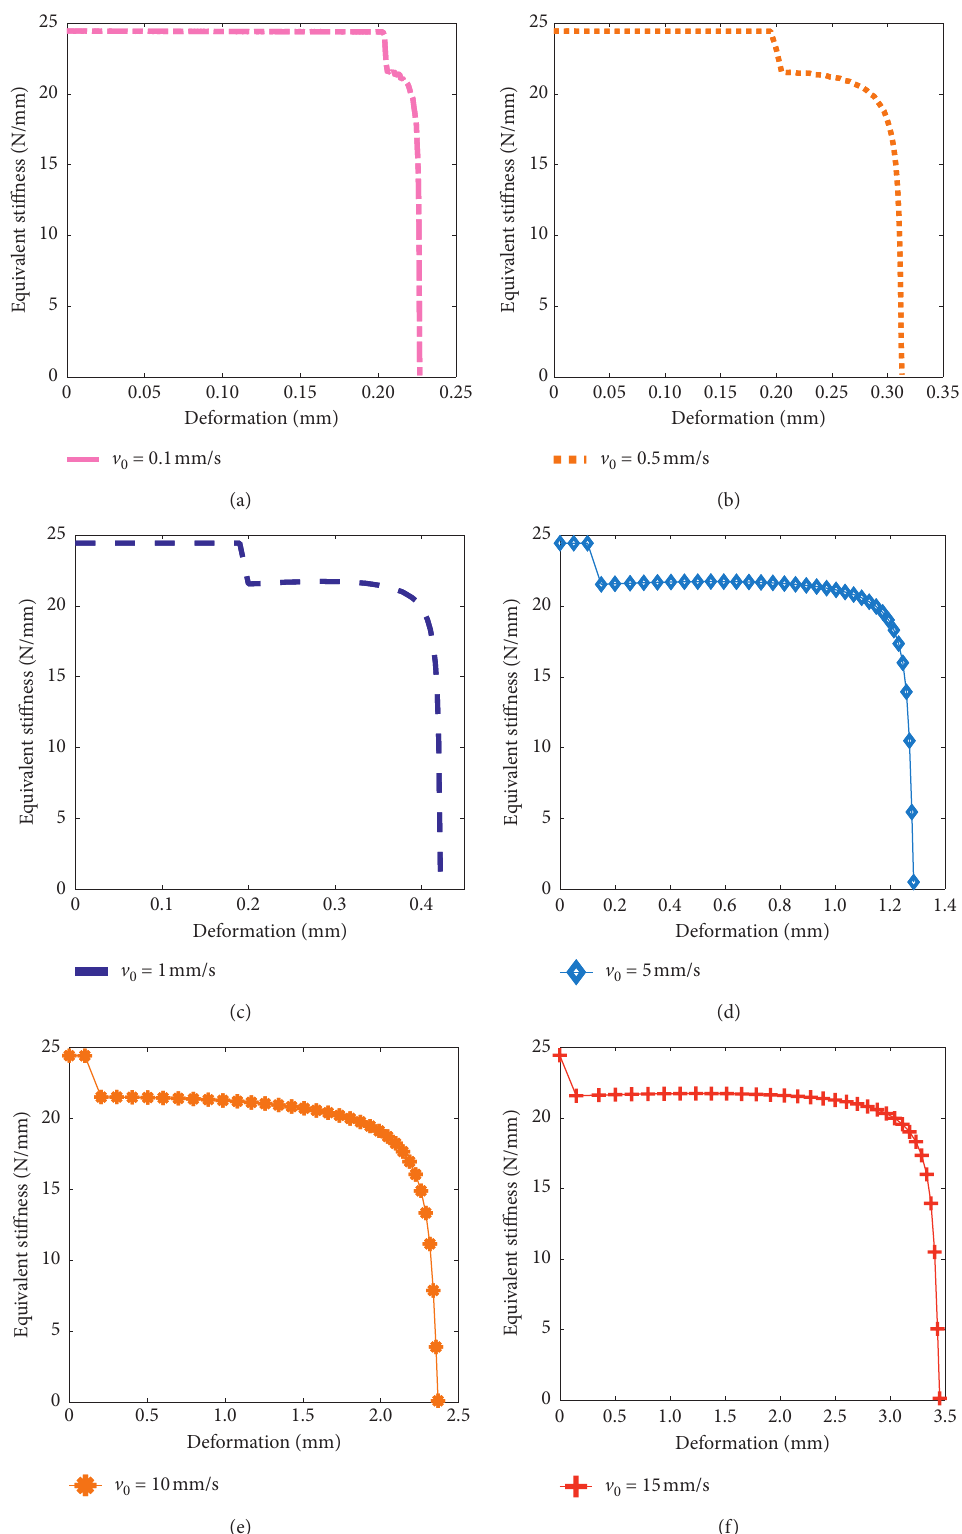
Figure 4: Curves of equivalent stiffness of grasping environment with fruit deformation at different grasping velocities. (a) v � 0.5mm · s − 1 . (c) v (b) v 0